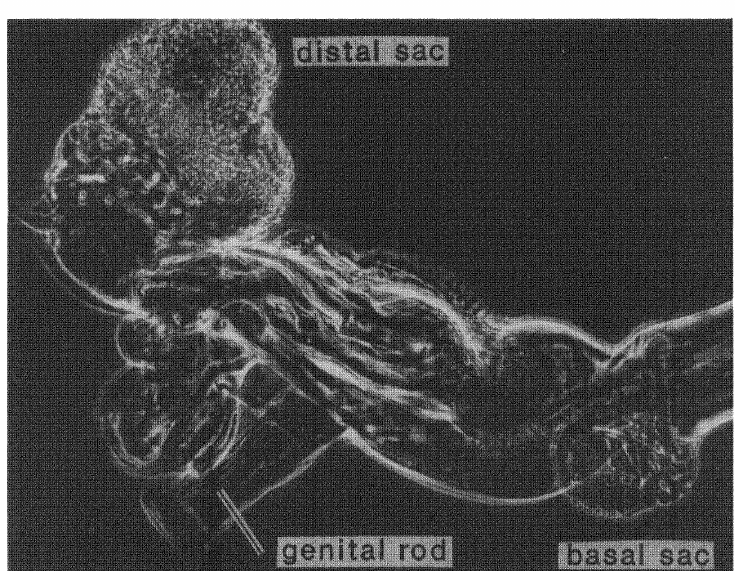
Fig. 3. The distiphallus of a male Ceratitis